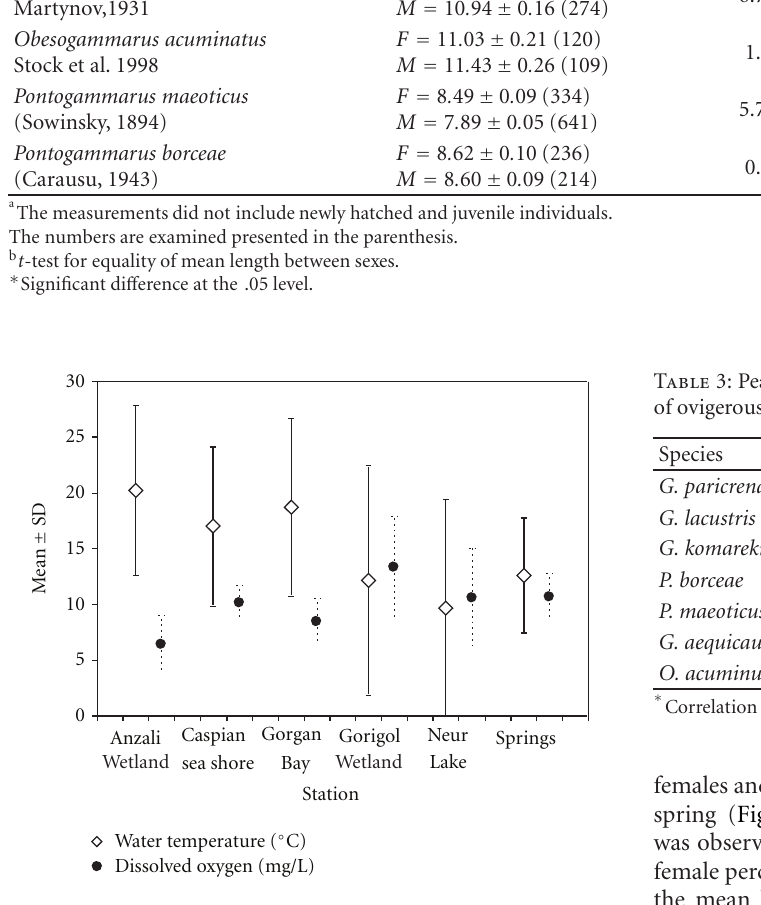
Figure 6: Water temperature and dissolved oxygen in sampling sites during April 2001 to March 2002.